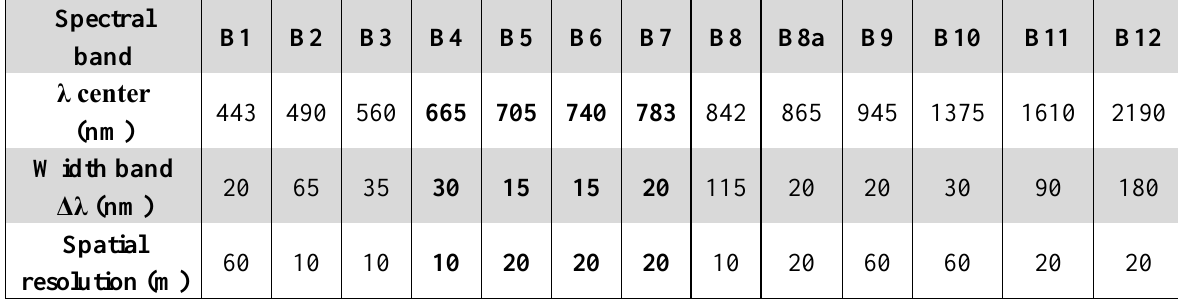
Table 1. S2 spectral specifications and spatial resolution [56]. The bands written in bold are those that fit within the NAOC integration